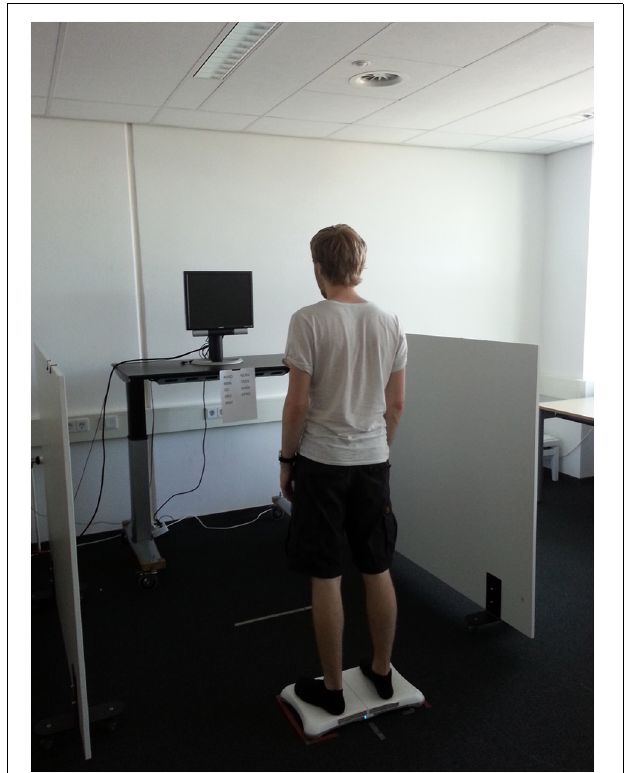
FIGURE 1 | Wii Balance Board